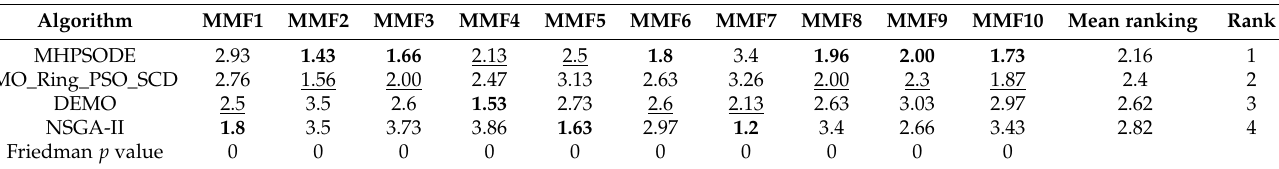
Table 5. Average ranks computed using the Friedman statistical test for all algorithms across all problems using CEC2009 benchmark, with the significance level α = 0.05.